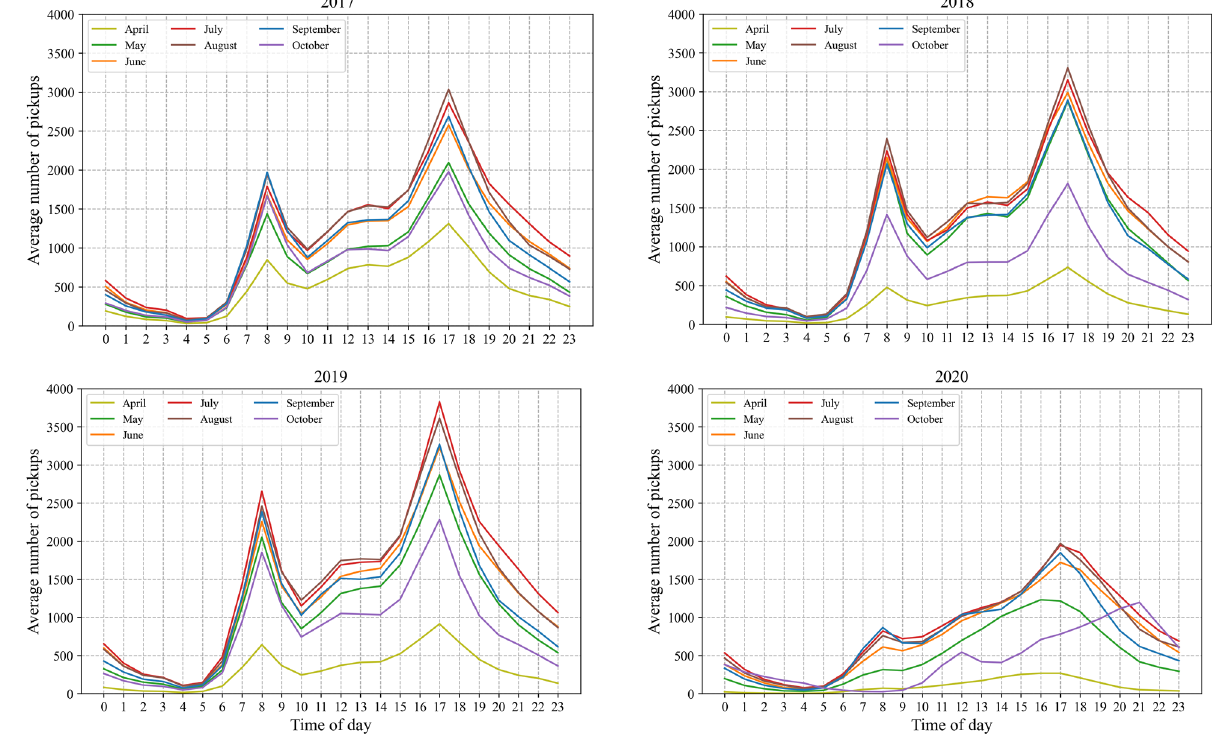
Figure 2. Frequency of use in time of day, per month, from 2017 to 2020.